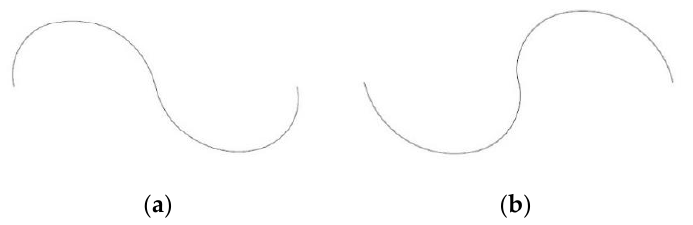
Figure 2. Profiles analyzed; ( a ) Fibonacci I; ( b ) Fibonacci II. Both profiles shown in Figure 2a,b, Fibonacci I and Fibonacci II, respectively, have been analyzed. The characteristics of these geometries are shown in Table 1. The parameters shown in this table are illustrated in Figure 3. As can be seen, the configuration Fibonacci II is obtained from Fibonacci I by simply inverting the order of the arcs, leading to a lower rotor diameter. Table 1. Characteristics of the analyzed wind turbines. Model